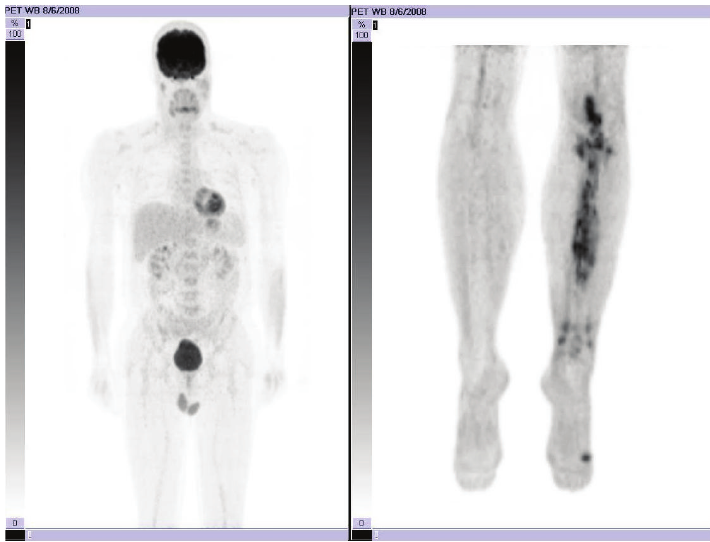
Figure 1: Pretreatment planar PET/CT image.